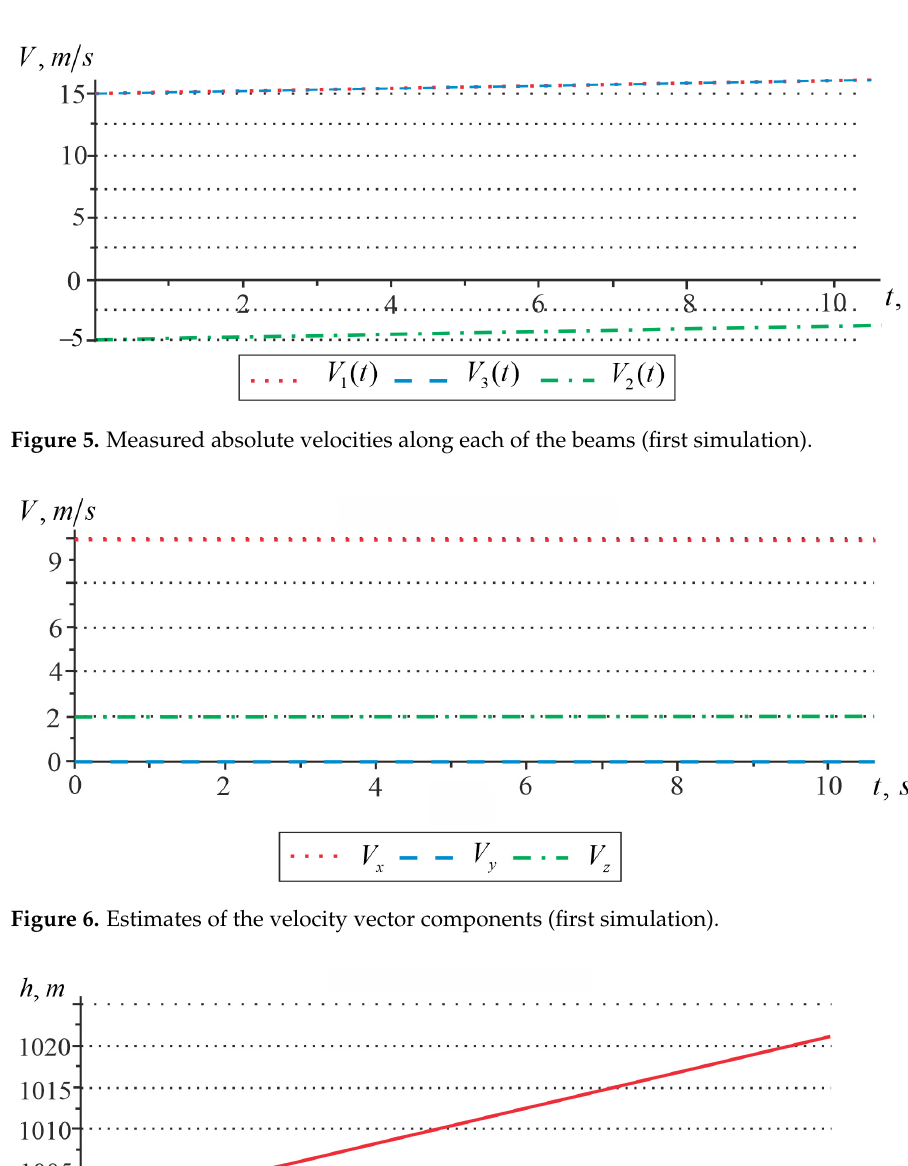
Figure 4. Variation in current distances along each of the beams (first simulation).